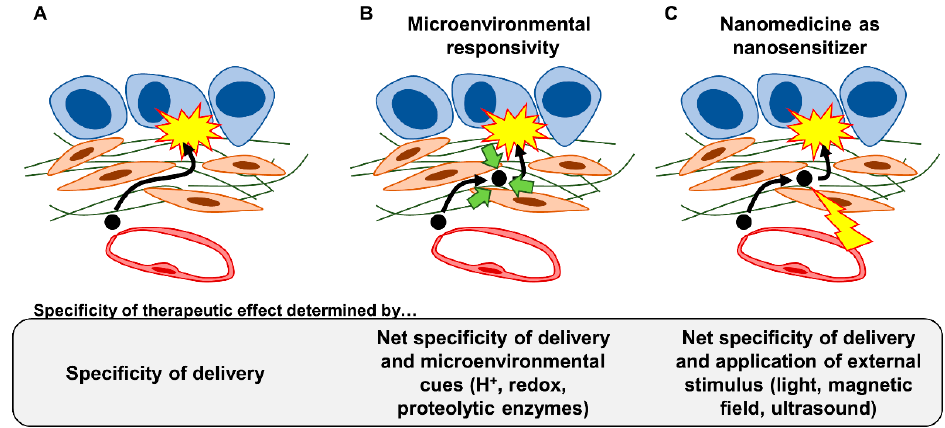
Figure 11. Increased specificity of the therapeutic effect via microenvironment-responsive nano- medicines and nanomedicines as nanosensitizers. While the specificity of the therapeutic effect of conventional nanomedicines is determined by the specificity of delivery ( A ), the installation of re- sponsivity to microenvironmental cues (light green arrows) allows an additional layer of control over specificity ( B ). Nanomedicines could also be designed to respond to an external stimulus (yel- low thunderbolt), in which they could be considered “nanosensitizers” ( C